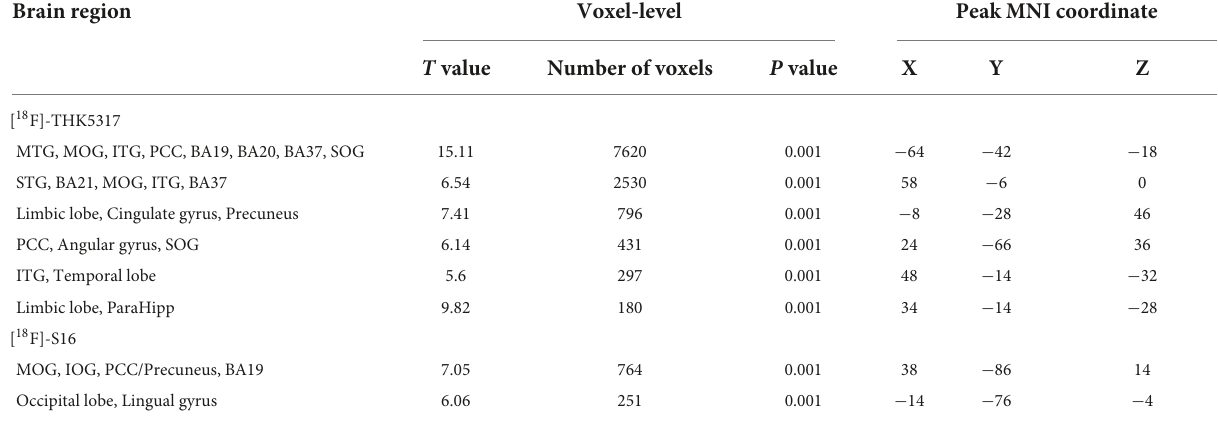
TABLE 2 Voxel-based analysis between AD and HC groups in both [ 18 F]-THK5317 and [ 18 F]-S16. Brain region Voxel-level Peak MNI coordinate T value Number of voxels P